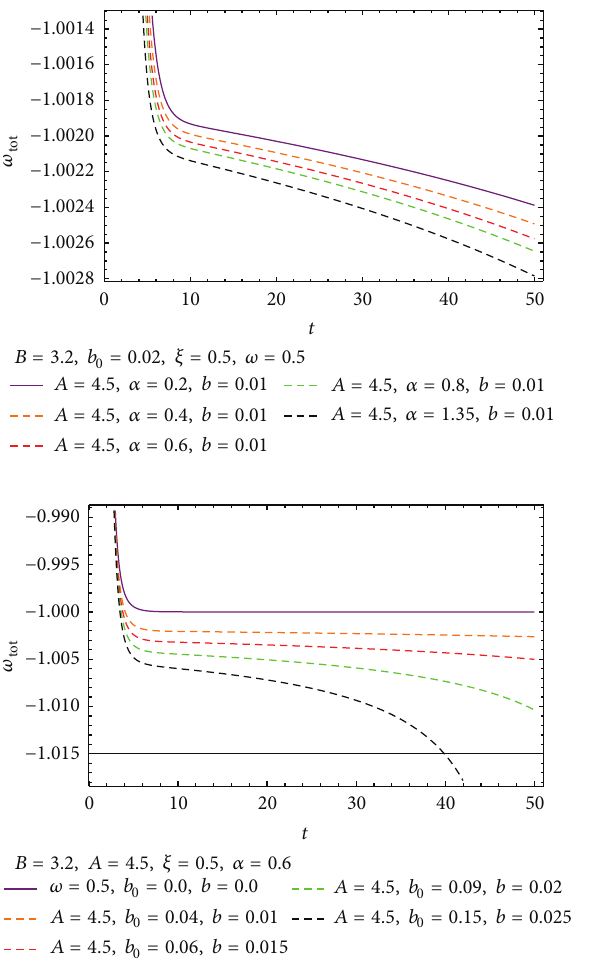
B = 3.2, b 0 = 0.02, 𝜉 = 0.5, 𝜔 = 0.5